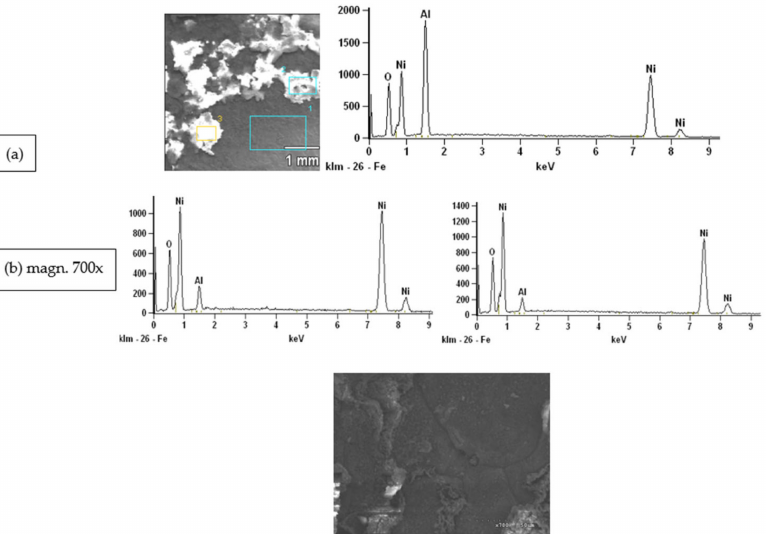
Figure 23. ( a ) Chemical composition of the Ni 3 Al intermetal surface in planes pt1, pt2 and pt3; ( b ) microscopic photo (SEM) of the Ni 3